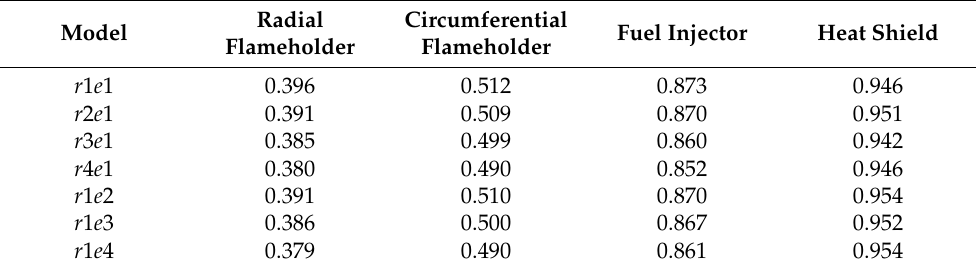
Table 4. Average cooling efficiency of components under cases with different cooling flow path structure